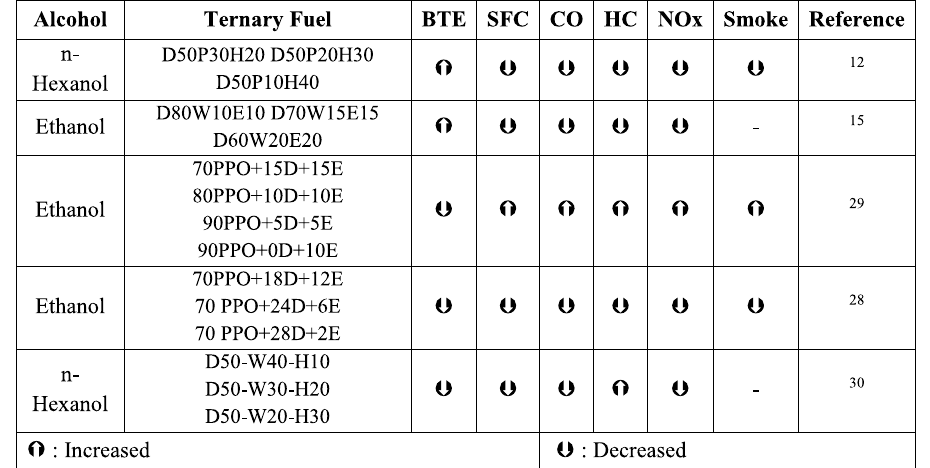
Table 2. Engine characteristics of alcohols with plastic fuel blends.